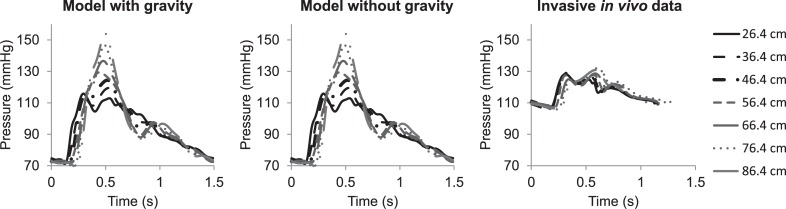
In vivo pressure waveforms compared with simulations, at seven locations along the aorta.Distances are expressed in centimetres distal from the aortic root.